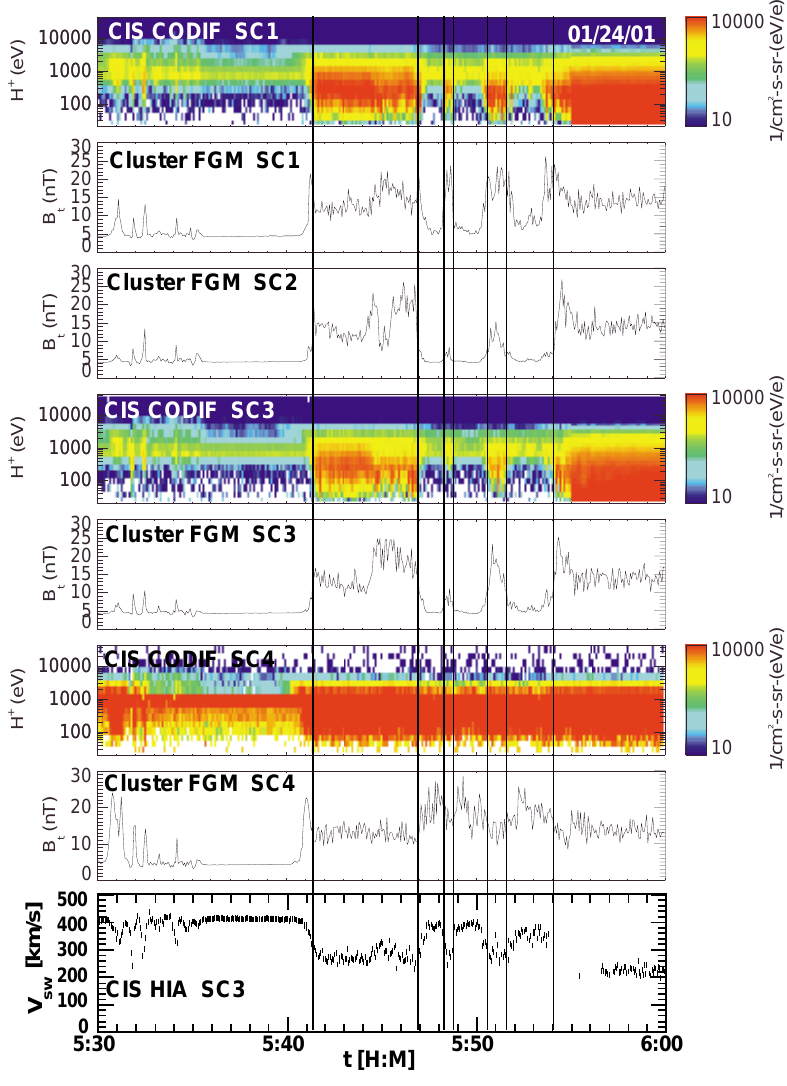
Fig. 1. From top to bottom: colored spectrogram of the H + differential par- ticle flux and the magnetic field mag- nitude B from spacecraft 1, B from spacecraft 2, H + and B from space- craft 3 and spacecraft 4, followed by the H + bulk speed from spacecraft 3 for the time period of 05:30–06:00 UT on 24 January 2001. The vertical lines indi- cate the bow shock crossings of space- craft